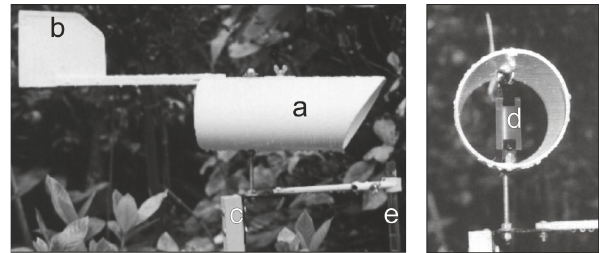
Figure 3: Spore trap made in PVC. References: (a) PVC capsule; (b) rectangular wing; (c) wood rod; (d) slide covered with Vaseline fixed at 135 ∘ to the front part of the capsule; (e) glass tube to collect